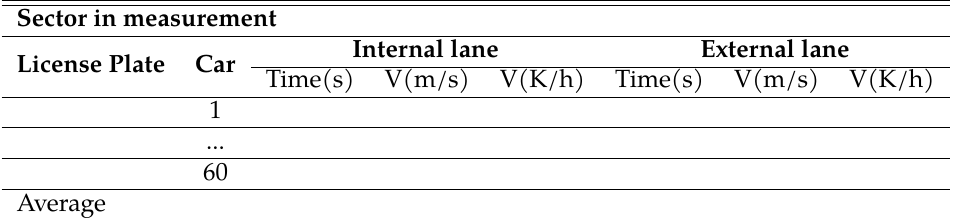
Table 2: Study of speeds according to sector, length, and schedule Sector in